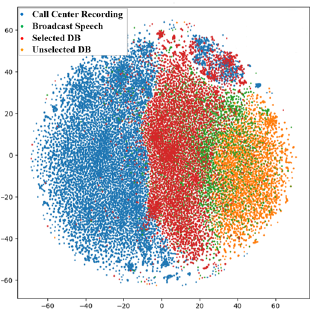
Figure 7. Spatial distribution of sequence-level attributes in the acoustic space of call center recordings,